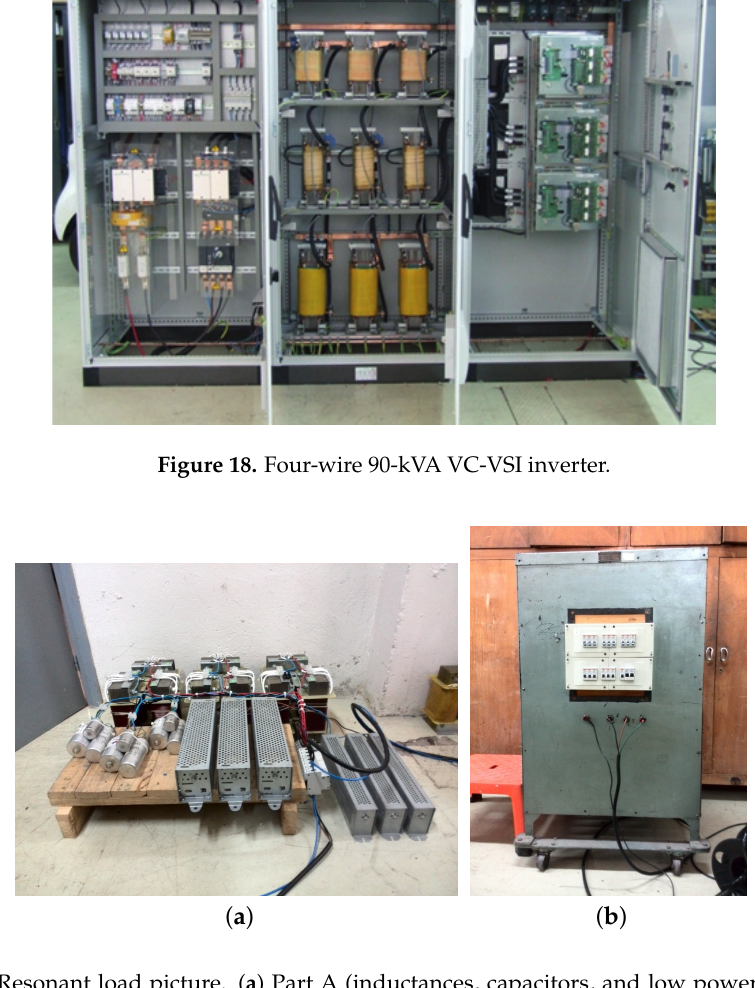
Figure 19. Resonant load picture. ( a ) Part A (inductances, capacitors, and low power resistances). ( b ) Part B (big resistive block).